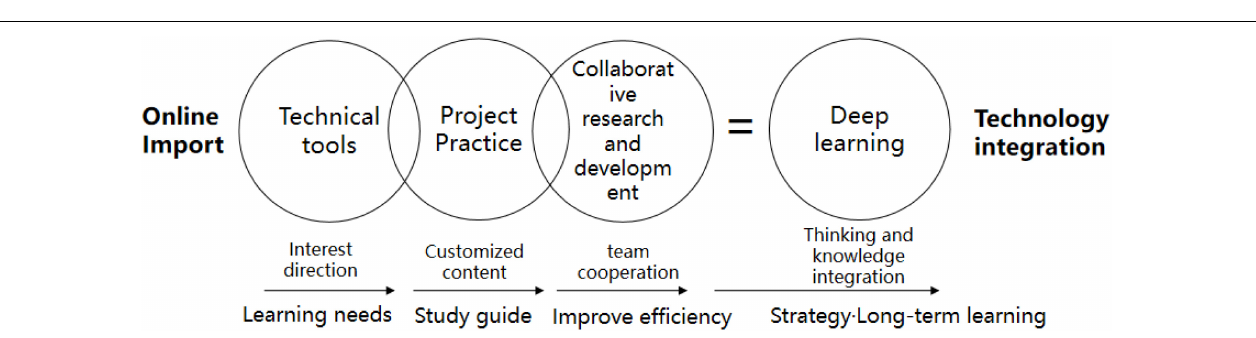
FIGURE 2 | Implementation integration of online design